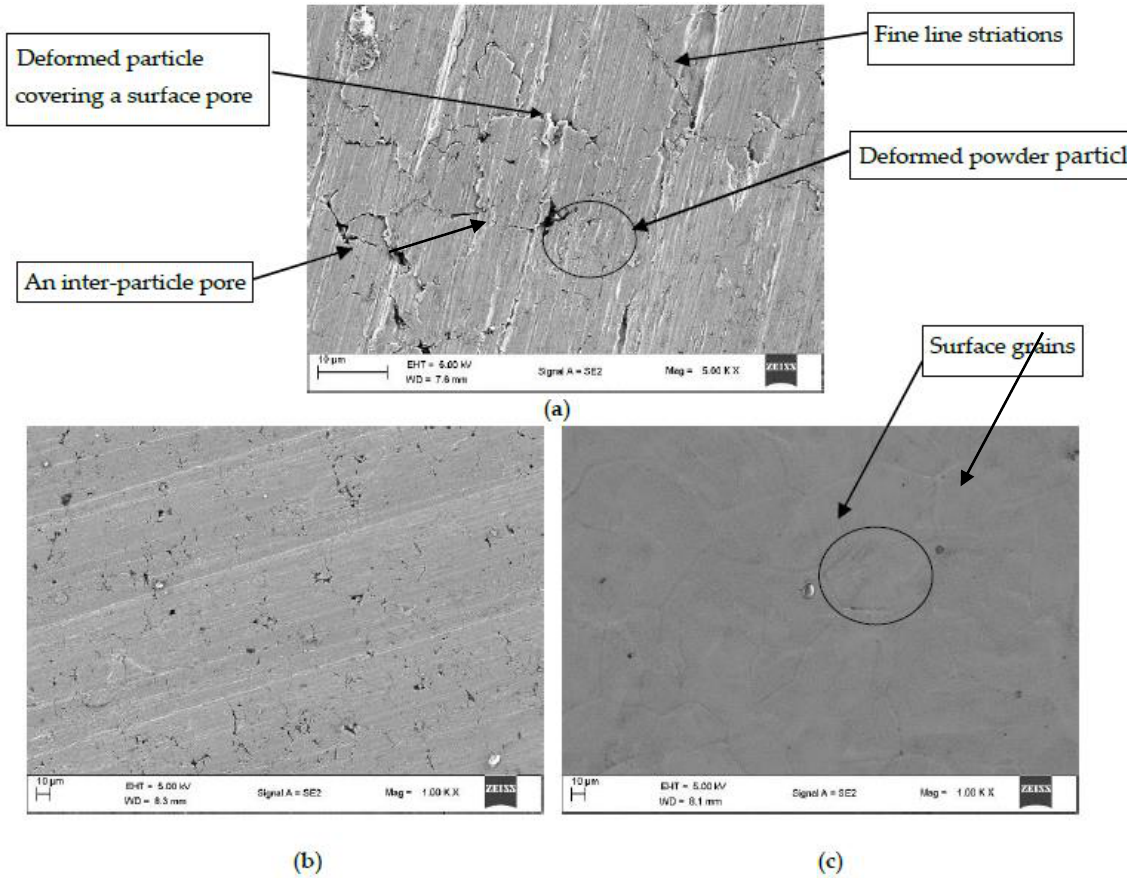
Figure 7. DPR (direct powder rolling) titanium strip surfaces: ( a ) green strip surface at 5000 × magnification; ( b ) green strip surface at 1000 × magnification; ( c ) sintered strip surface at 1000 × magnification.